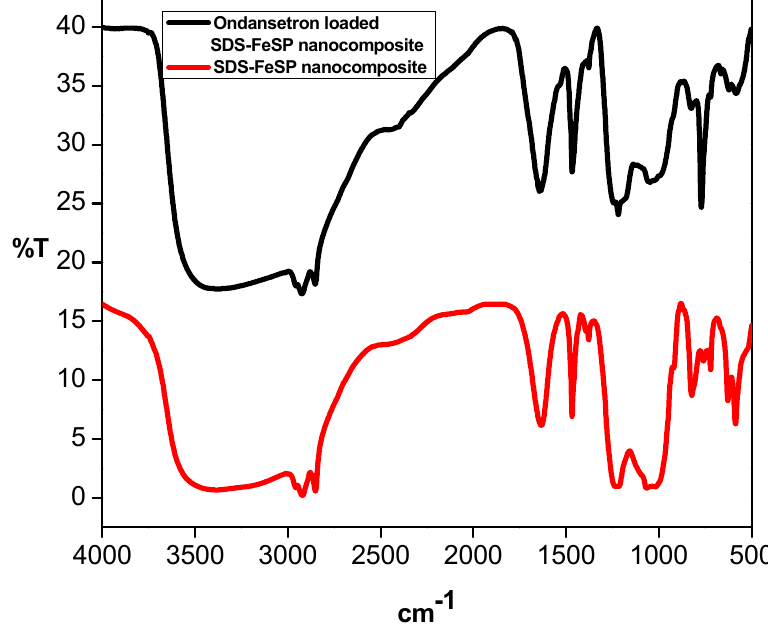
Figure 1. FTIR spectra of ondestron-loaded SDS-FeSP and SDS-FeSP nanocomposite [25]. SEM images of SDS/FeSP nanocomposite at different magnifications are shown in Figure 2a,b. The surface morphology clearly showed the fibrous and granular appearance with smooth edges of